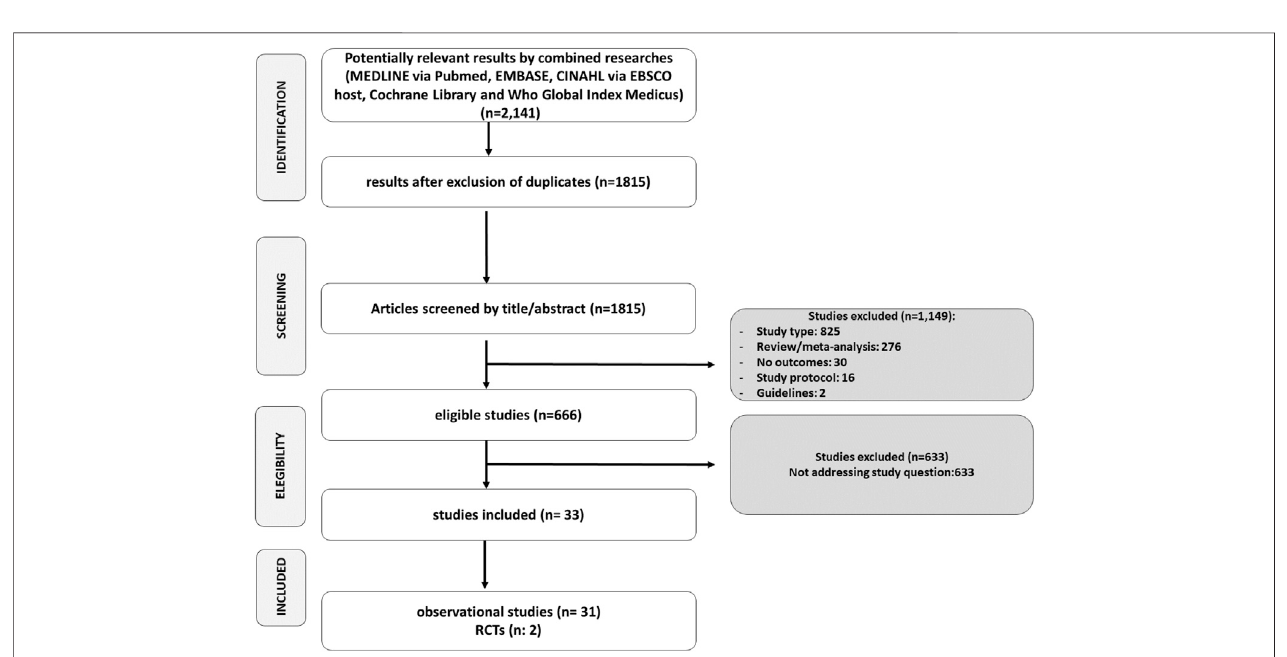
FIGURE 2 | PRISMA fl ow